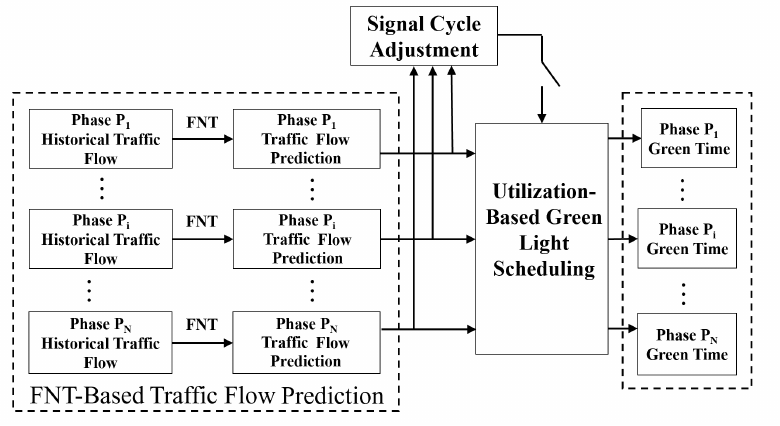
Figure 3. Framework for traffic light